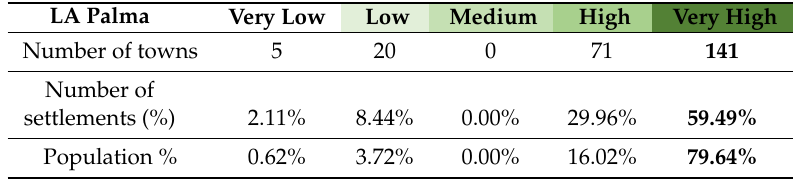
Table 7. Outcomes regarding the demographic dynamics and urban agglomerations classified according to the accessibility levels in the Island of La Palma (Source: authors). LA Palma Very Low Low